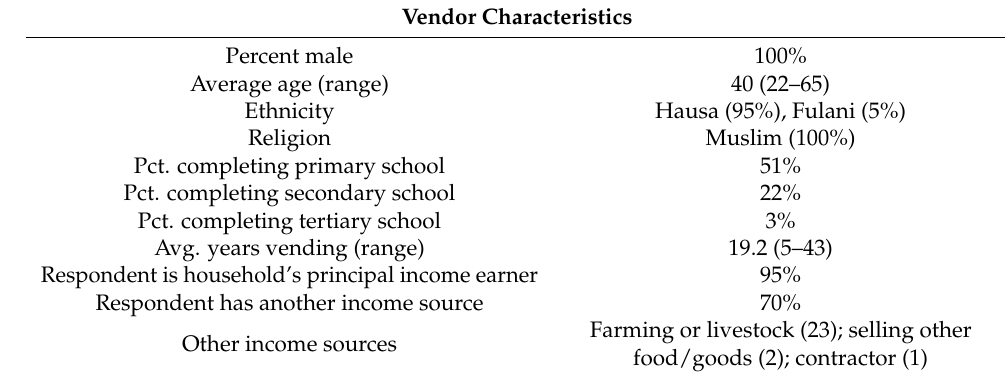
Table 2. Vendor demographic characteristics ( n =